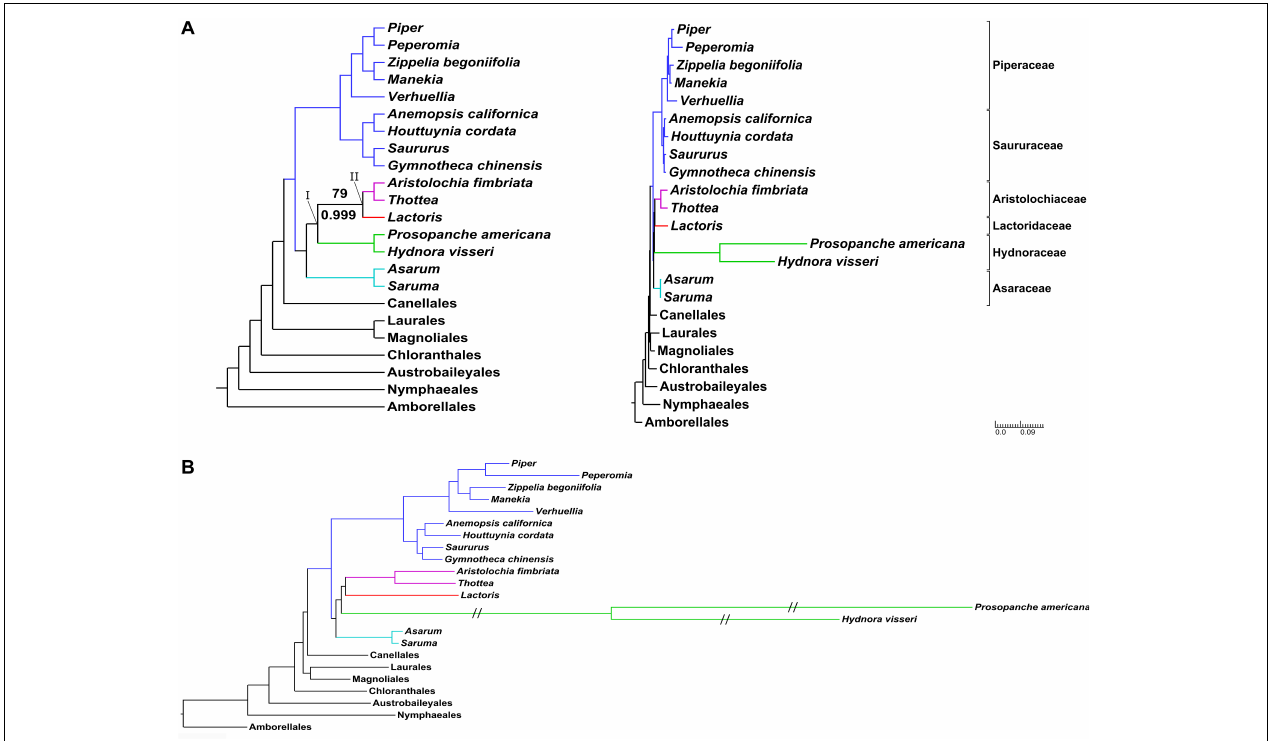
FIGURE 3 | Piperales phylogeny based on genome-partitioned 137 loci of three subcellular genomes. (A) Topology with full support (BS 100%, PP 1) for all nodes, unless indicated for maximum likelihood analysis (bootstrap, above the branch) and Bayesian inference (posterior probability, below the branch). The right side shows the phylogram with annotated families of the Piperales. (B) Amplified view of branch lengths within Piperales. Branches annotated with “//” are shortened by 50%. Piperales are color-coded: Asaraceae in turquoise, Aristolochiaceae in purple, Lactoridaceae in red and Hydnoraceae in green, Piperaceae and Saururaceae in